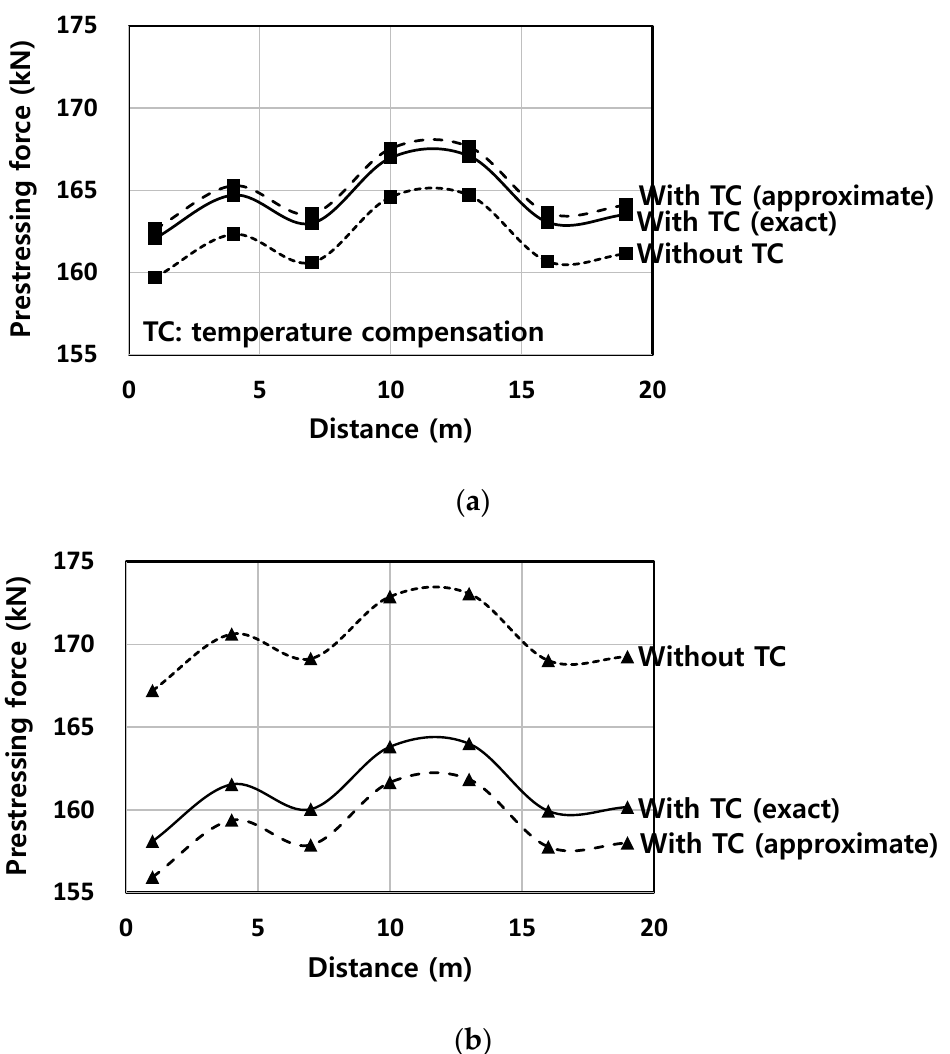
Figure 11. Effect of TC on PF distribution: ( a ) 91 days after tensioning; and ( b ) 198 days after ten- sioning.